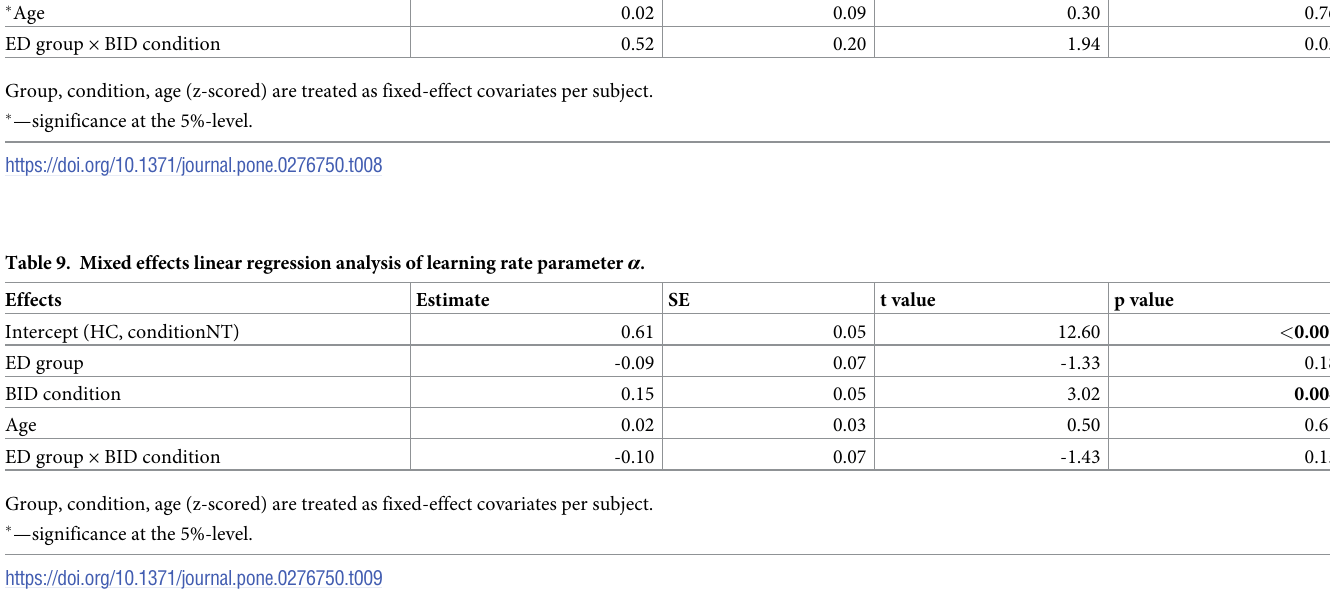
Table 8. Mixed effects linear regression analysis of model-free learning parameter β